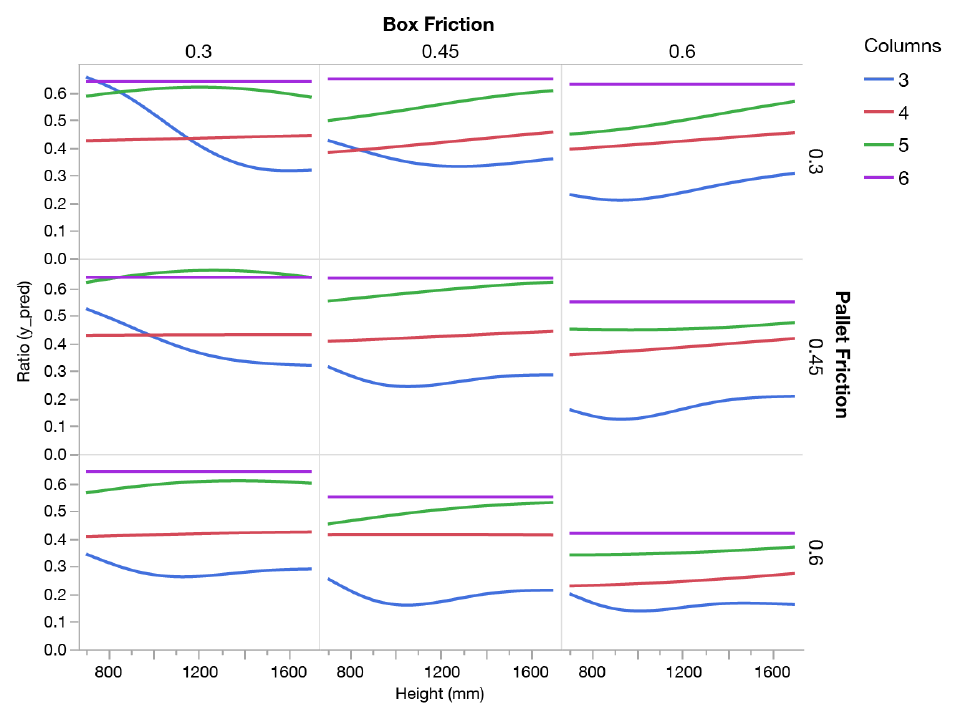
Figure 10. Finite element model simulations for 3, 4, 5, and 6 columns and three combinations of payload height and pallet and box friction coefficients. ( a ) Low pallet friction with short payload height; ( b ) high pallet friction with tall payload height; and ( c ) low pallet friction with tall payload height. Colors shown represent displacement (U). Blue equals no movement, red equals large displacements.